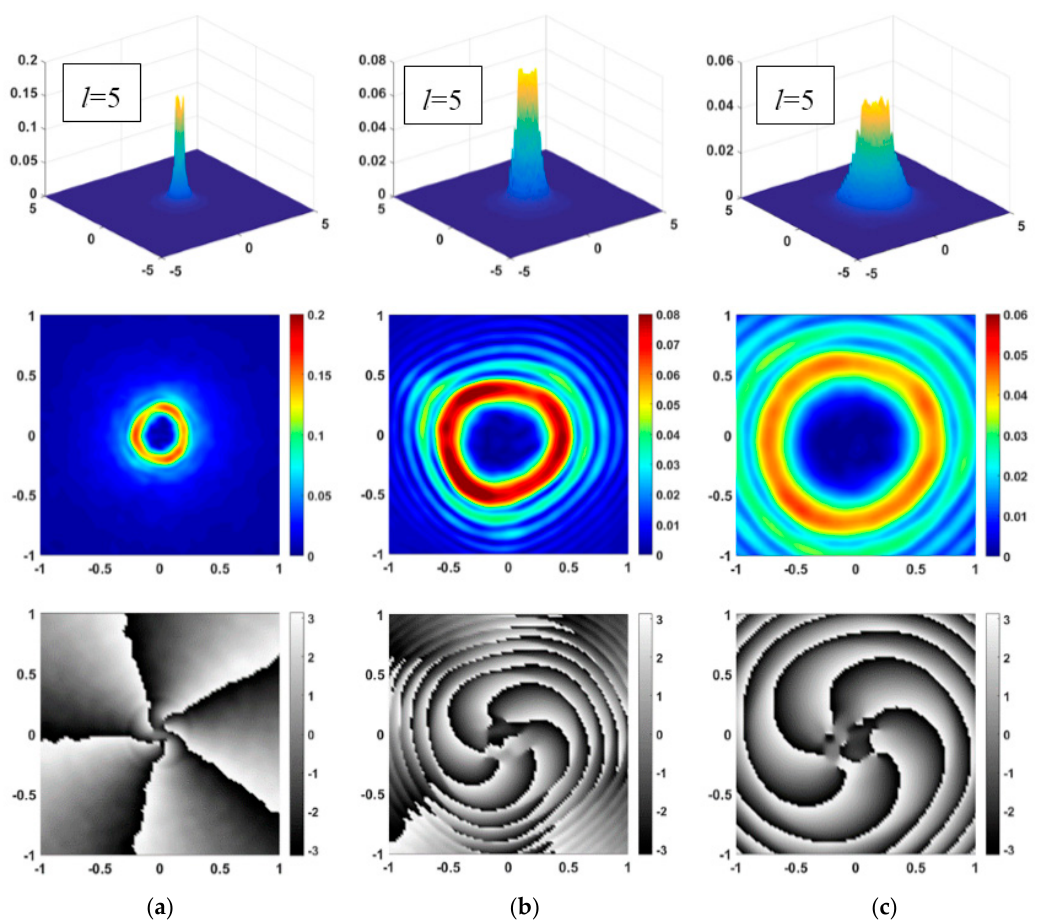
Figure 5. Intensity and phase distribution of electromagnetic vortex waves with transmission distances of ( a ) 1 km, ( b ) 5 km and ( c ) 10 km, with adaptive